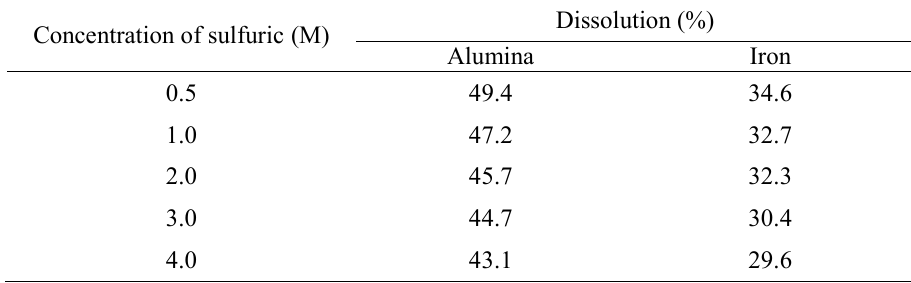
Table 7. Effect of acid concentration on the extraction of alumina and iron with a 2:3 ratio of calcined clay to ammonium sulfate, calcination at 400 o C for 120 min, and leaching with 200 mL of sulfuric at 90 o C for 180 min.